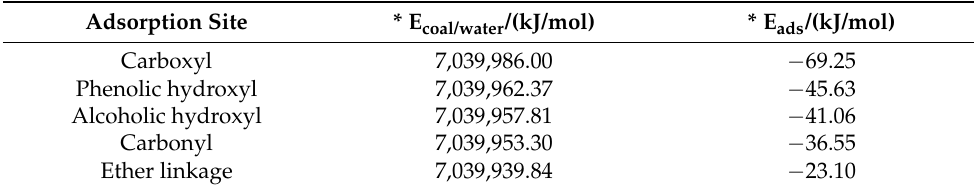
Table 2. Adsorption energy of water molecules acting on different oxygen-containing functional groups of a lignite model (data from